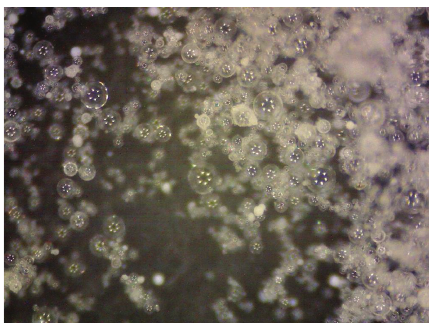
Figure 1: Micron-grade cenosphere which has been magnified 200 times.